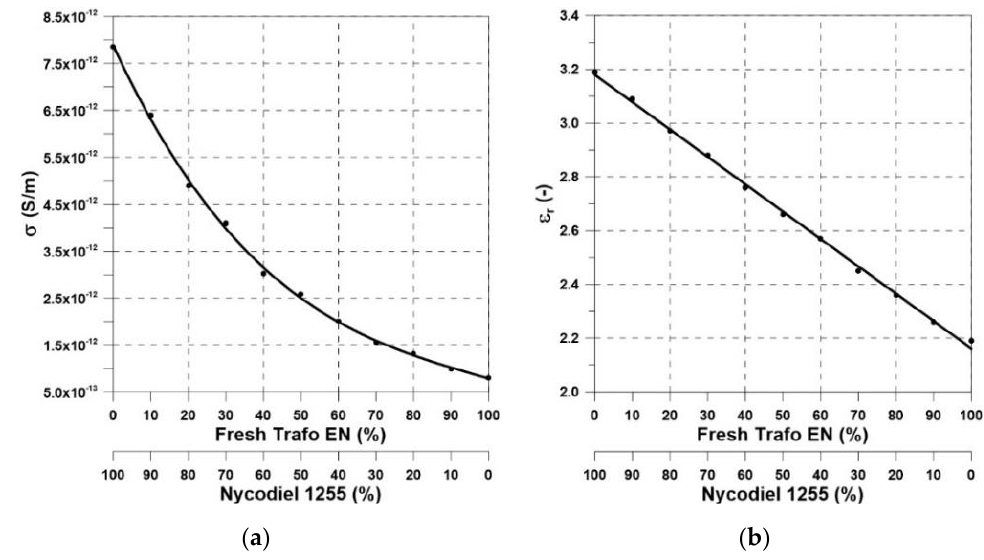
Figure 3. ( a ) Conductivity and ( b ) relative dielectric constant vs. mixing of Nycodiel 1255 synthetic ester with fresh Trafo EN mineral oil.